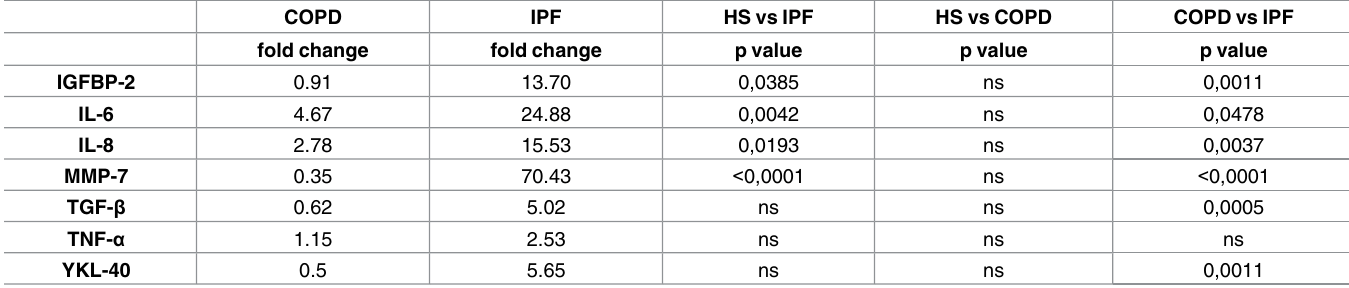
Table 5. Sputum cell gene